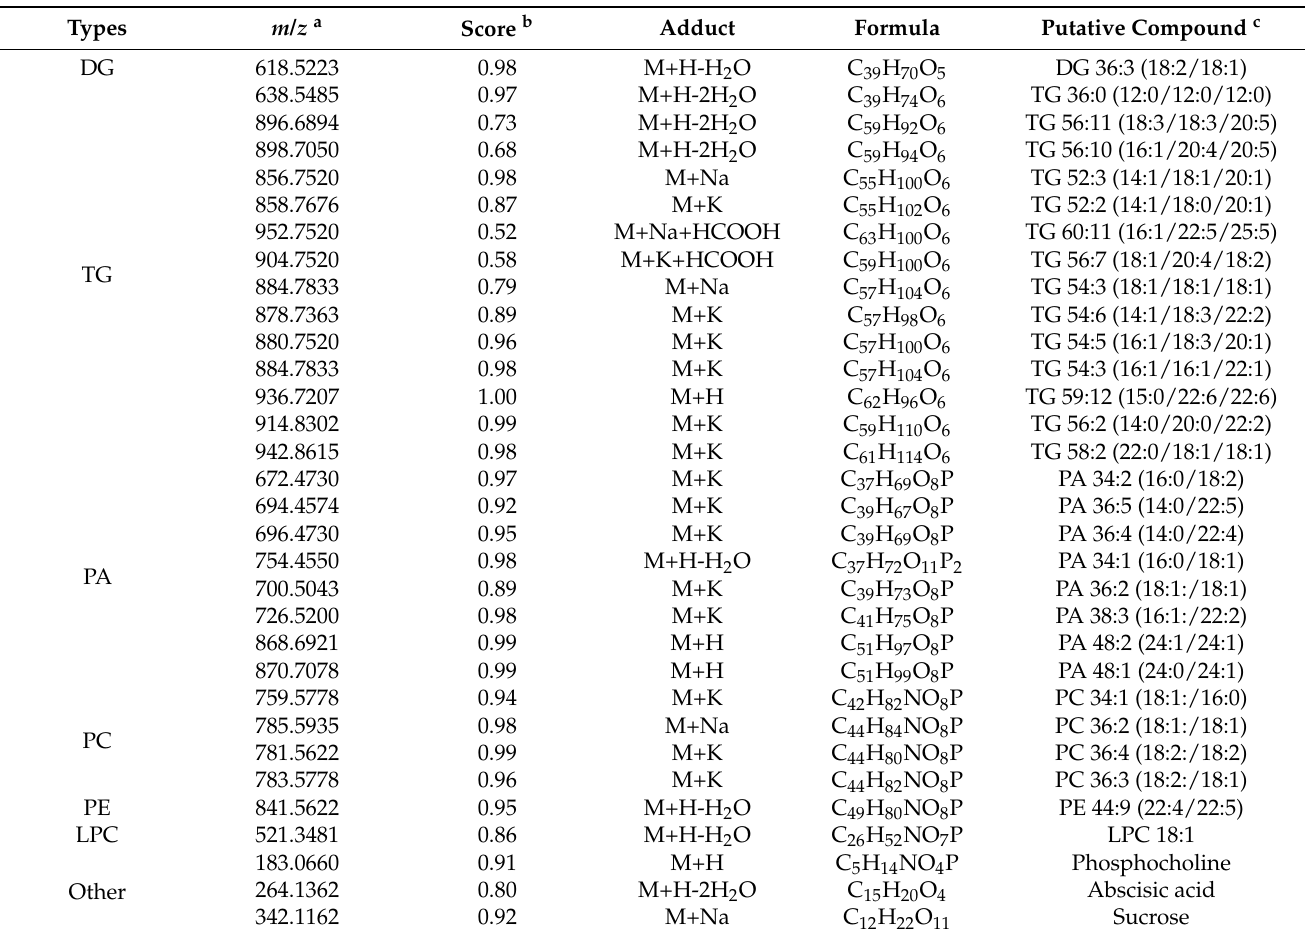
Table 1. The information of lipids and major compounds putatively identified by MALDI-MSI. a the measured accurate mass of the parent ion of compound, b score was obtained from the highest matched compound in a self-built database MWD and publicly available metabolite databases, and c 14 triacylglycerols (TG), 8 phosphatidic acids (PA), 4 phosphatidylcholines (PC), one diacylglycerol (DG), one lysophosphatidylcholine (LPC) and one phosphatidylethanolamine (PE) were putatively identified in the samples.